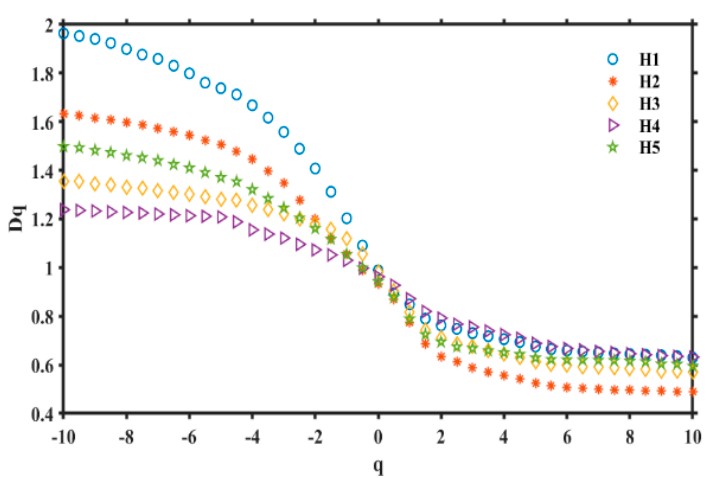
Figure 7. Variations in the generalized dimension D q with respect to q in di ff erent depth layers. Based on the characteristics of the seismicity and seismotectonic structure and zonation in the Taiwan region, the study area is first divided into east and west seismic tectonic zones. Furthermore, the eastern seismic tectonic zone is further divided into the Ryukyu arc (RK), TaiDong valley (TD), and Luzon arc (LZ). The western seismic tectonic zone is divided into the XinZhu fault (XZ), BeiGang uplift (BG), and Southwest basin (SB). The multifractals of each depth layer in di ff erent regions are calculated, and the results are shown in Figure 8.